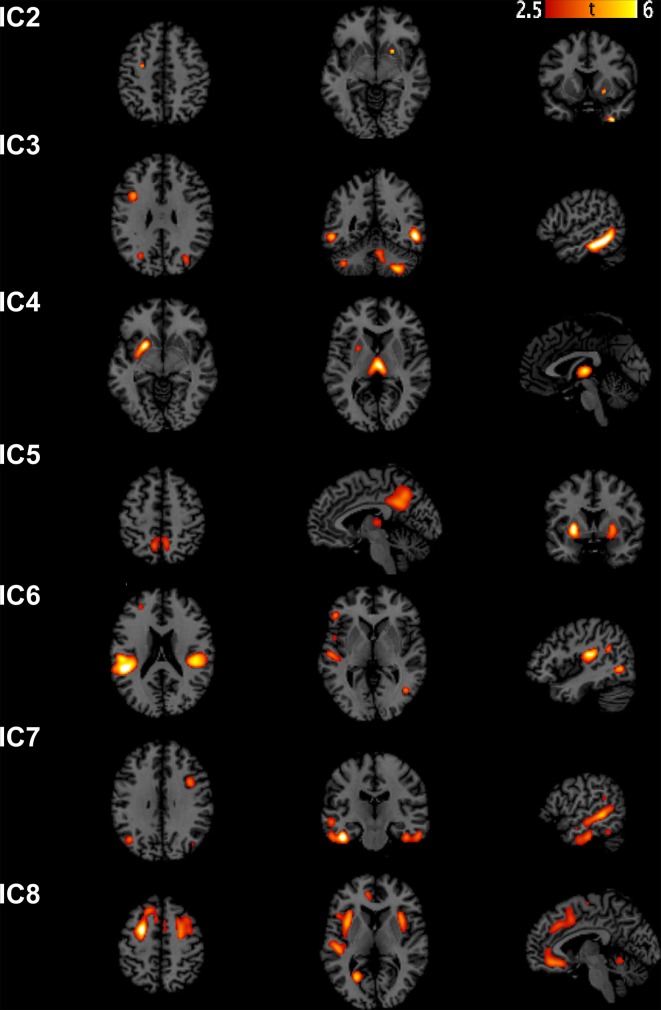
Sources discovered by SBM. According to the estimation of the number of components, eight independent components were extracted. Note that IC1 is not graphically represented because no voxel survived after thresholding for Z > 2.5.